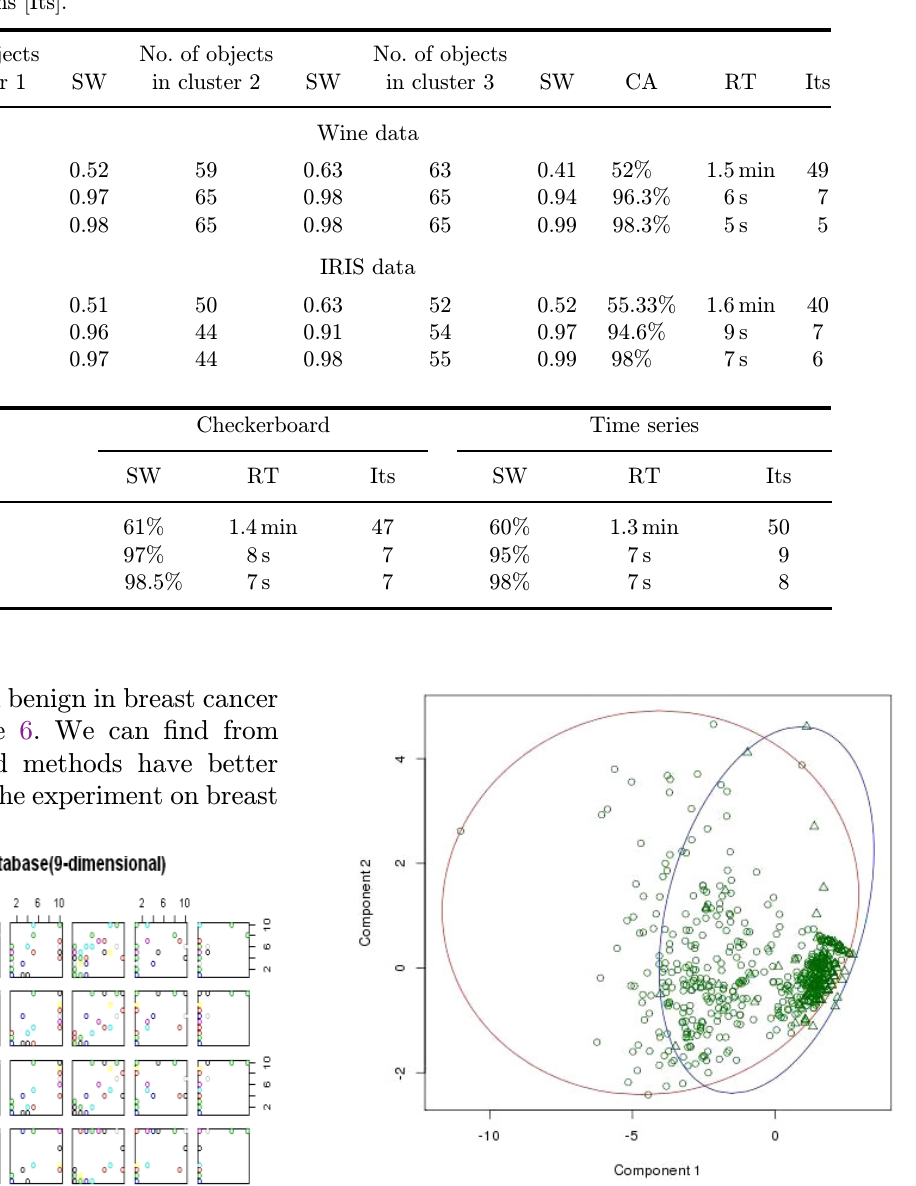
Fig. 22. Size of clusters by